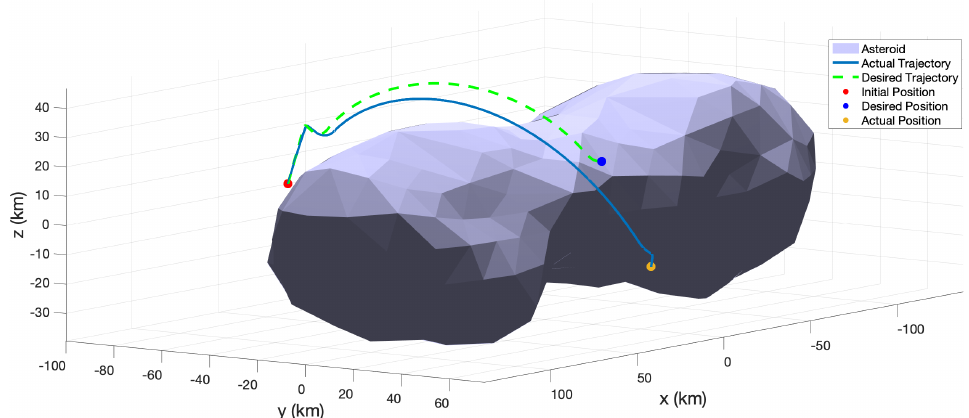
Figure 5. Trajectory of spacecraft around asteroid Kleopatra for MPC feed–forward.